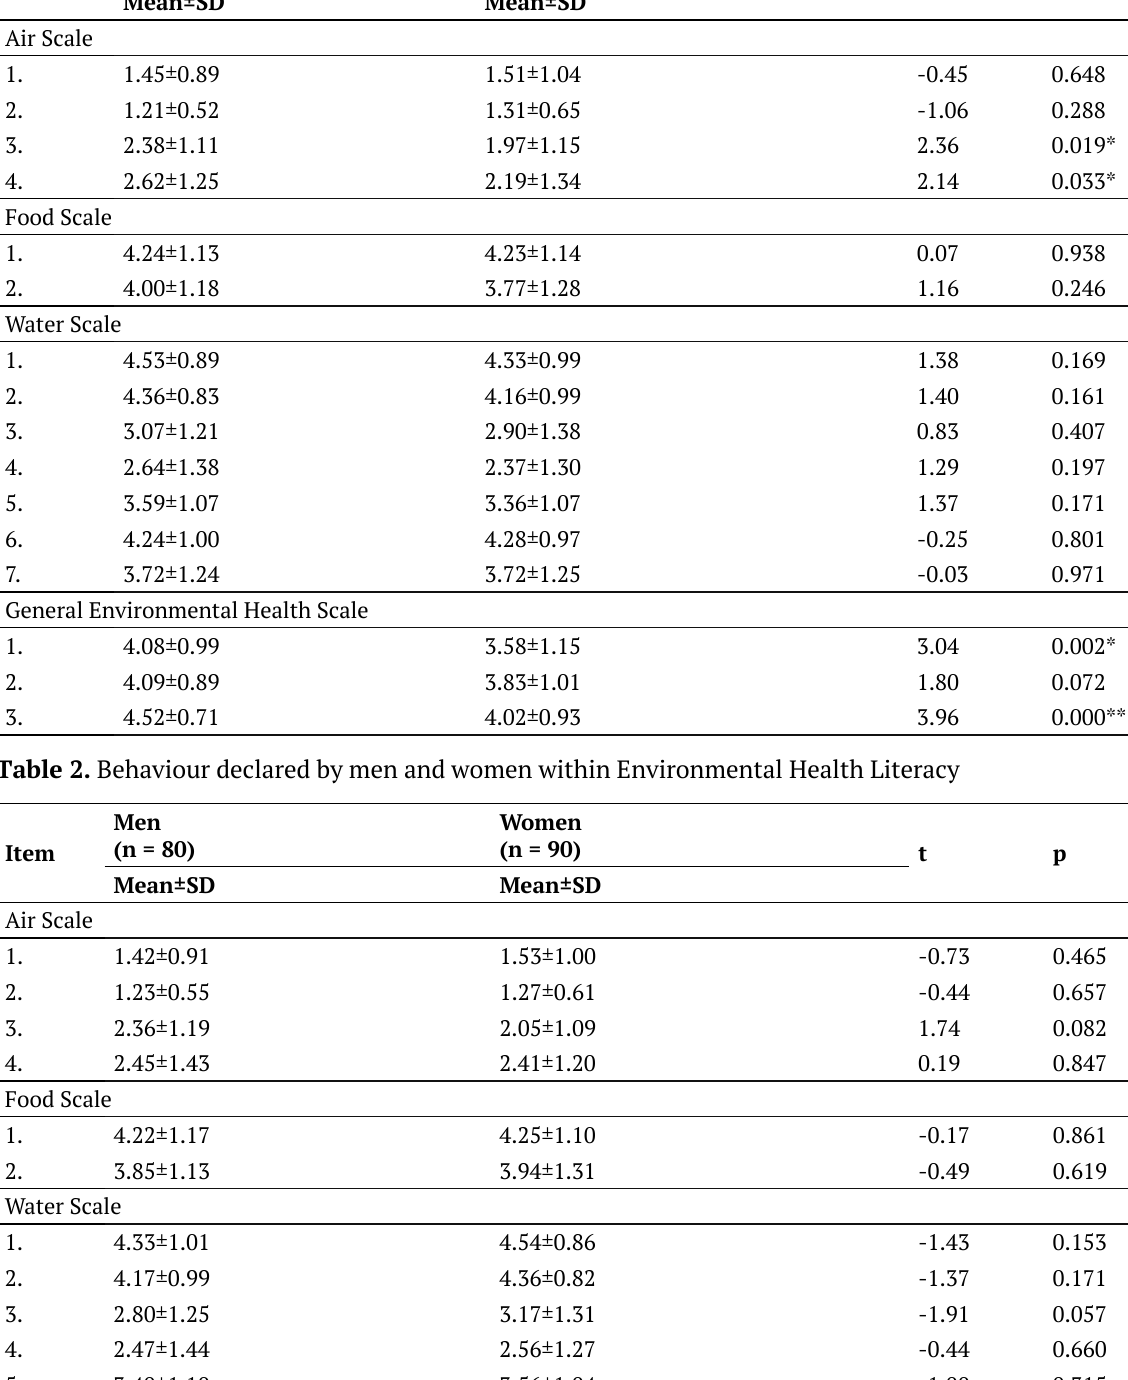
Table 1. Behaviours declared by outdoor and indoor athletes within Environmental Health Literacy Item